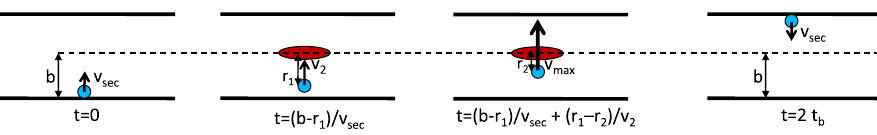
FIG. 5. Diagram of a two-bunch multipacting resonance. From left to right: a secondary electron is released from the bottom wall with speed v . It receives a kick from a passing bunch, and continues with higher velocity ( v 2 ). It is kicked again by a second bunch, sec bringing its speed up to v . Finally, it hits the wall, releasing another secondary electron at time t ¼ 2 t b max